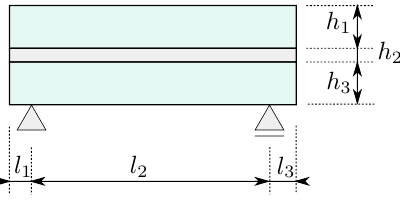
Figure 2. Scheme of laminated glass sample.